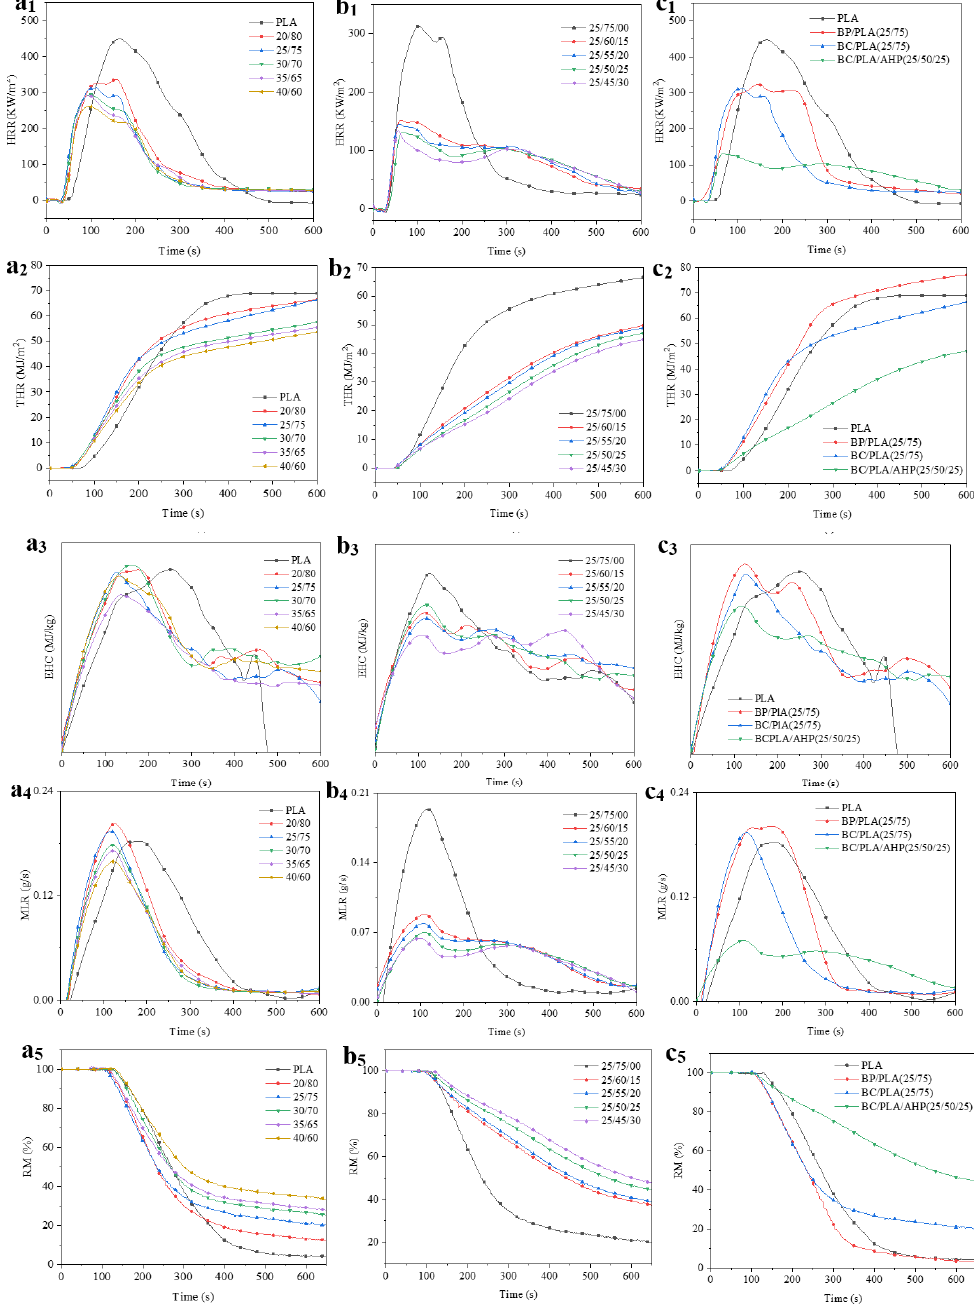
Figure 8. Heat release rate (HRR), total heat release (THR), effective heat of combustion (EHC), mass loss rate (MLR) and residue mass (RM) curves for: ( a 1 –a 5 ) BC/PLA, ( b 1 –b 5 ) BC/PLA/AHP and ( c 1 –c 5 ) BP/PLA.